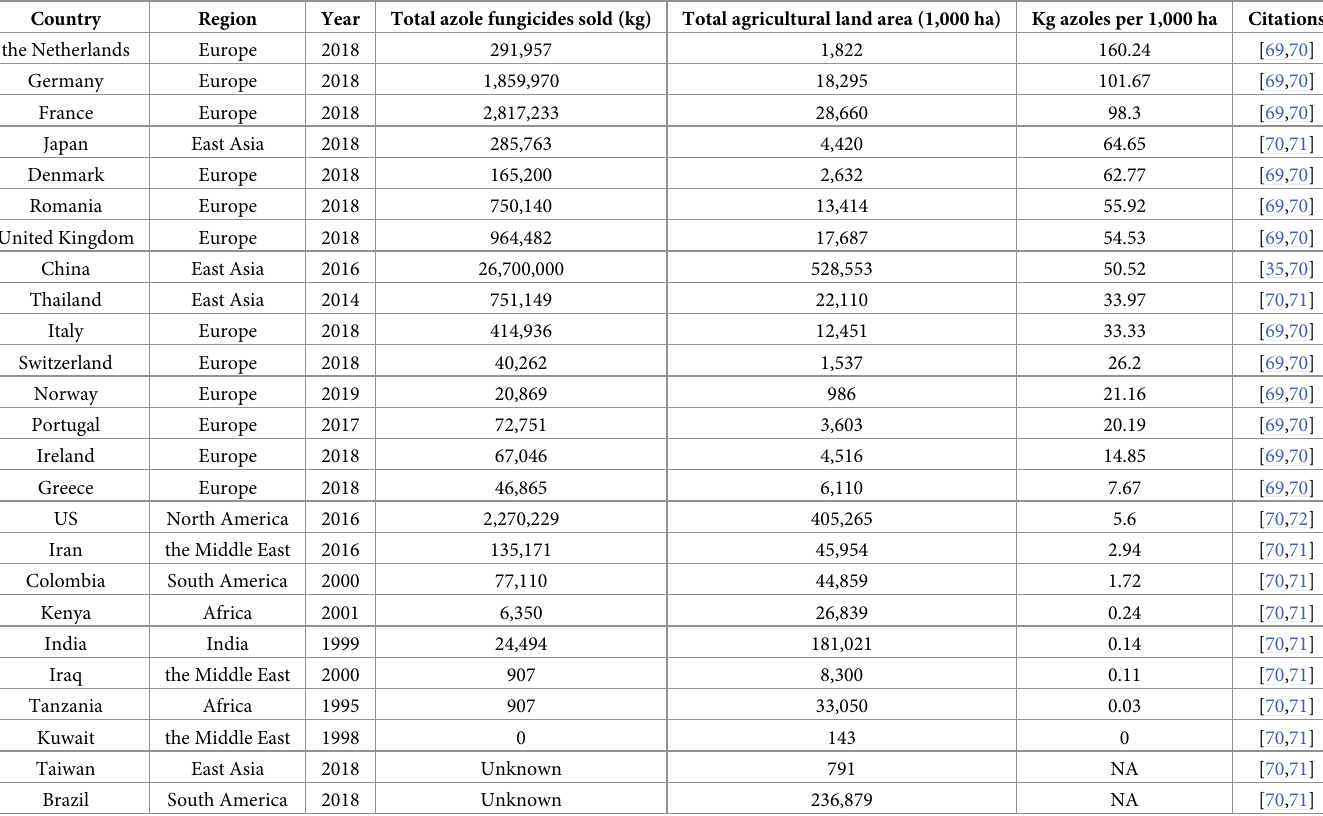
Table 1. Azole fungicide application in agricultural